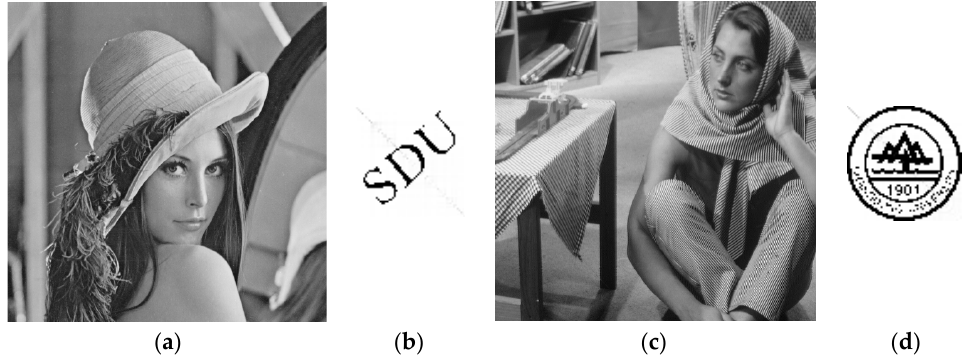
Figure 11. Watermarked images and extracted watermarks under JPEG (100): ( a ) watermarked Lena; ( b ) extracted watermark w 1 ; ( c ) watermarked Barbara; ( d ) extracted watermark w 2 . (2) Salt and pepper noise (0.01 and 0.05).